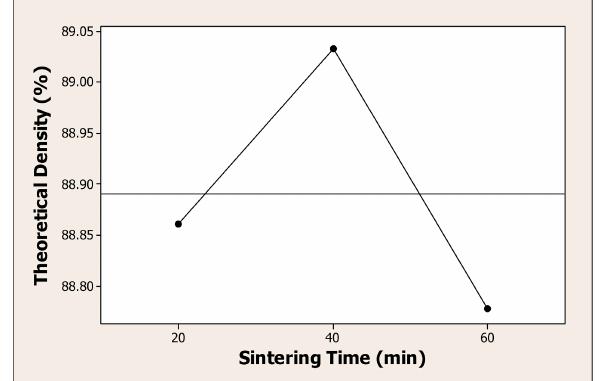
Figure 6. Effects of sintering temperature on the hardness of AZ31 magnesium alloy. Figure 7. Effects of sintering time on sintered density of AZ31 magnesium